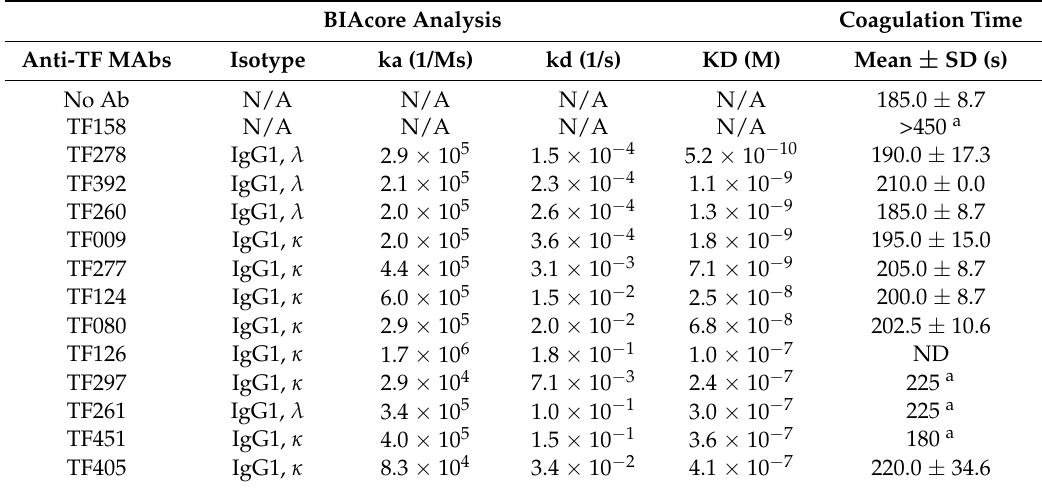
Table 2. Isotypes, affinities, and anti-blood coagulation activities of anti-human tissue factor monoclonal antibodies [38] (reproduced with permission from Chen et al. Hybridoma. 2005;